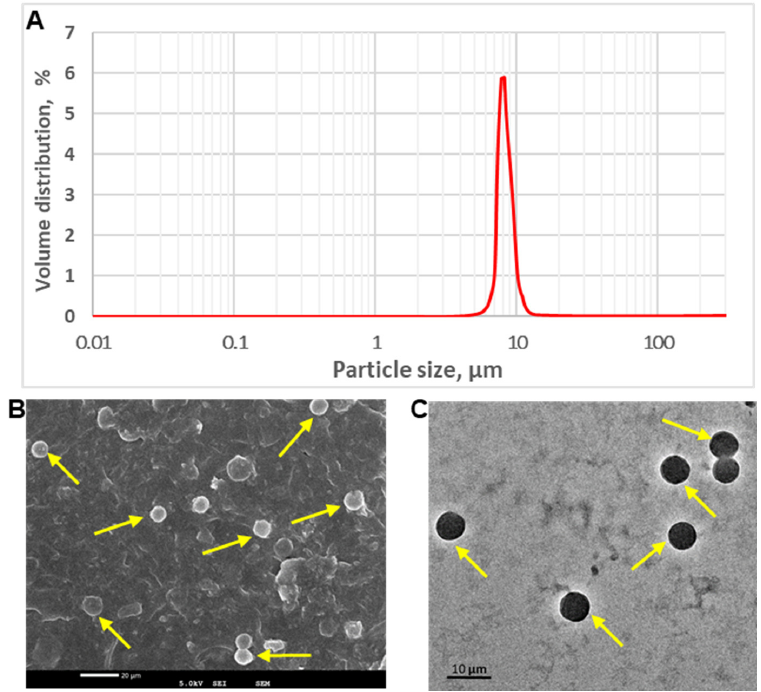
Figure 1. Representative graph showing particle size analysis ( A ), SEM image ( B ) and TEM image ( C ) of dexamethasone-loaded microspheres.